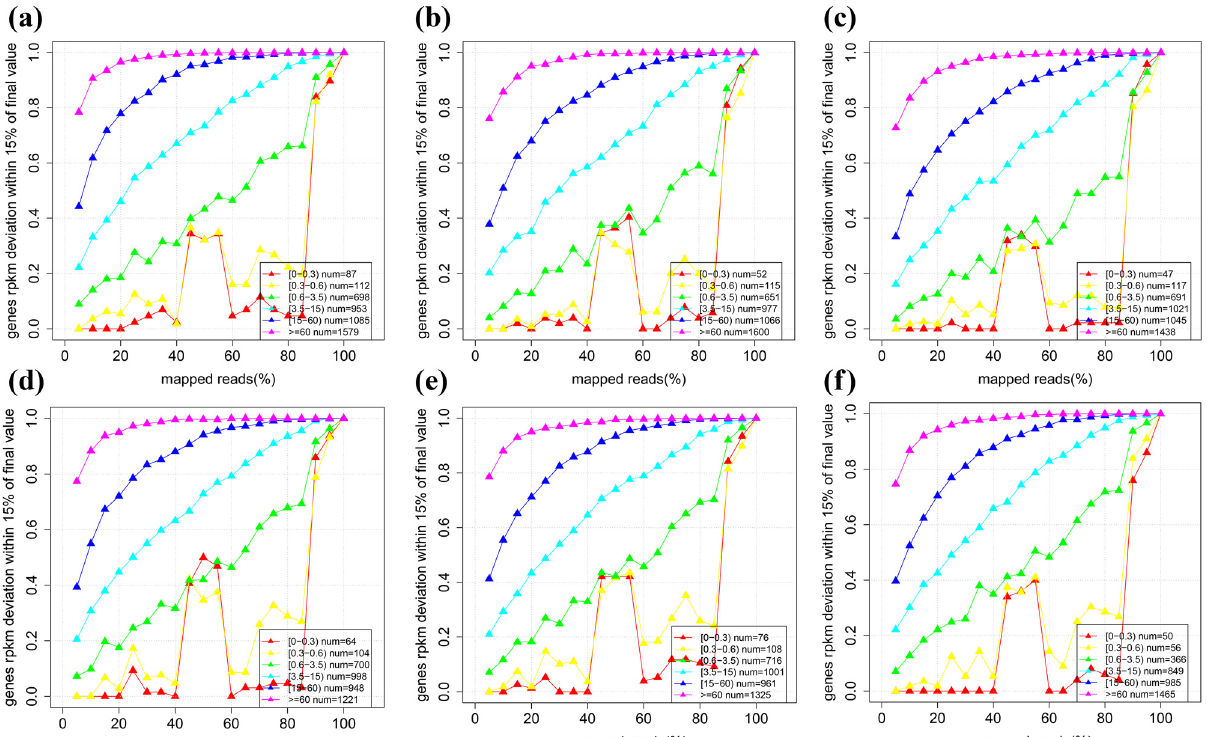
Figure 2: Trend lines of sequenced saturation curve. ( a – f ) represent SX4 - CK - 1, SX4 - CK - 2, SX4 - CK - 3, SX4 - 1, SX4 - 2, and SX4 - 3, respectively.